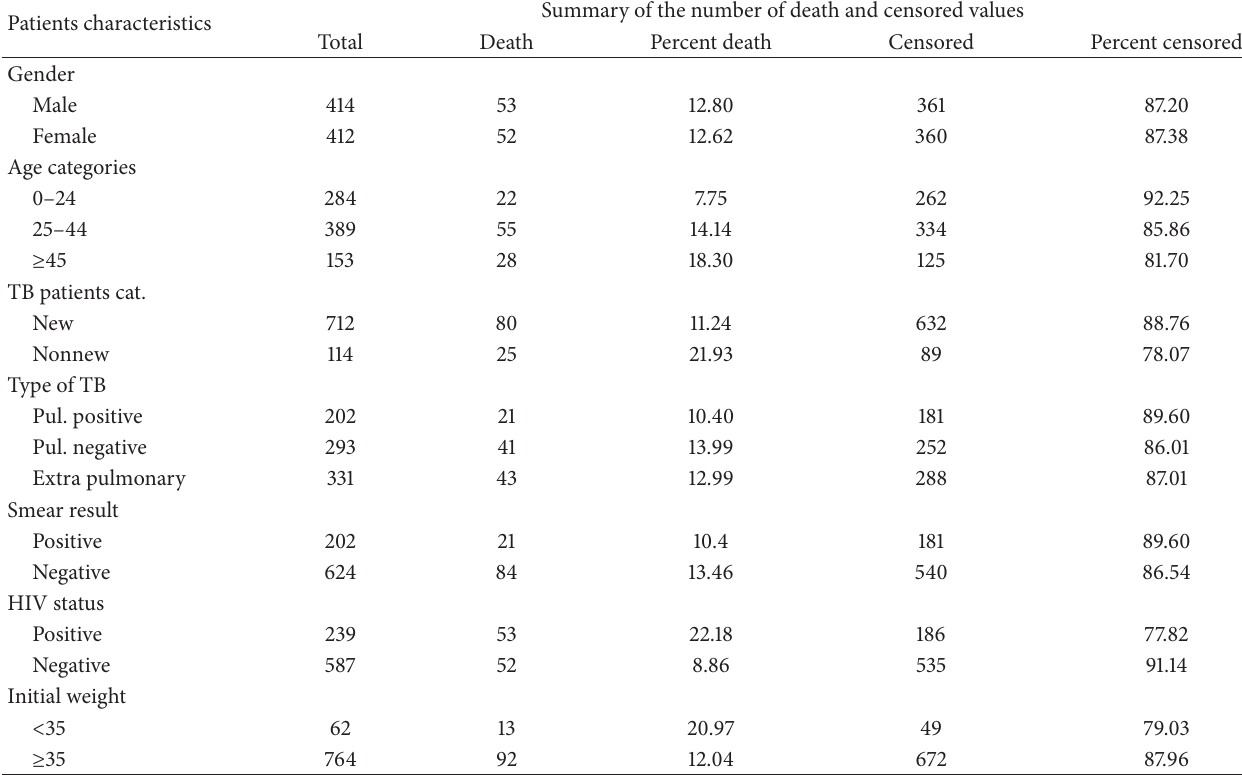
Table 1: Characteristics of tuberculosis patient data under DOTS from six randomly selected governmental health centers in Addis Ababa, Ethiopia, from September 2011 to August 2012.